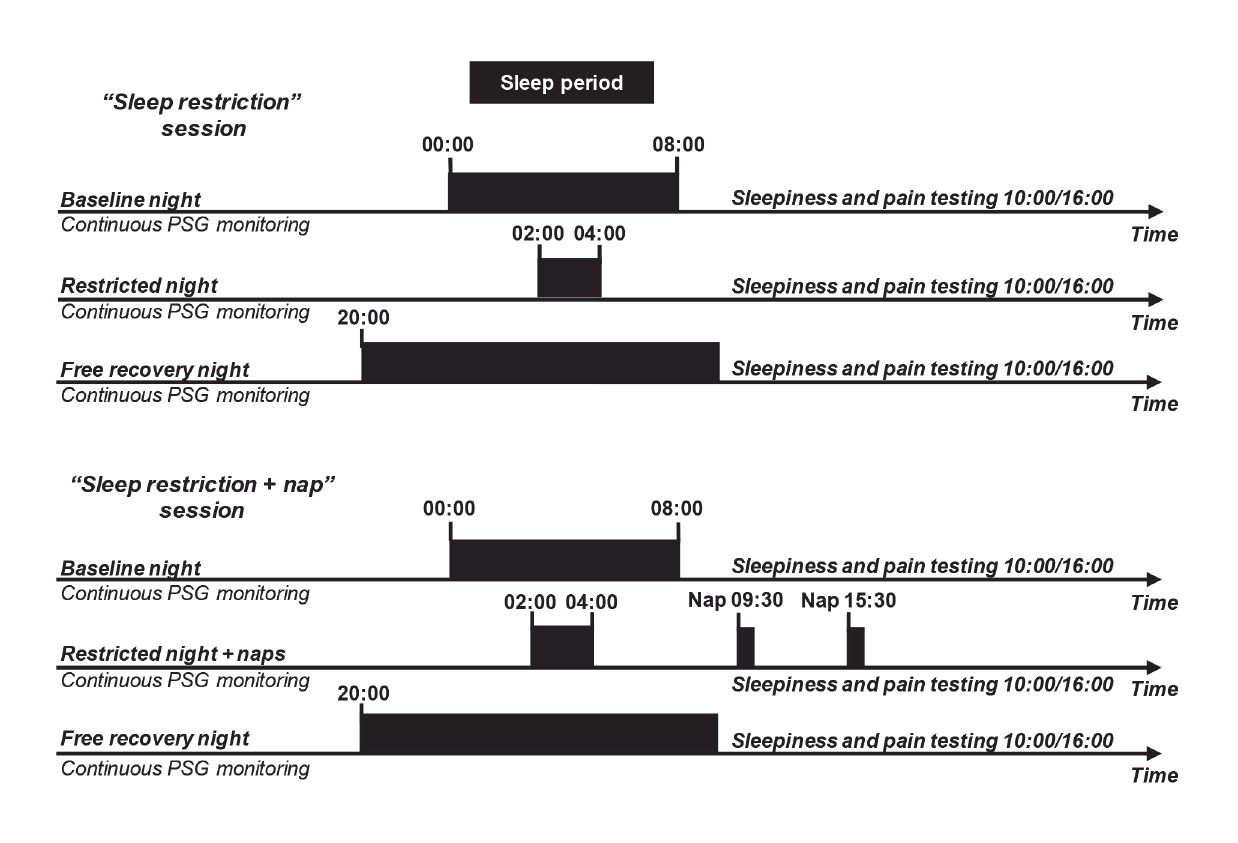
Fig 1. Experimental design. The experimental design included two three-day sessions, during which continuous ambulatory polysomnography (PSG) recordings were taken for each volunteer. The volunteers were randomly allocated to two groups, one of which started with the “ sleep restriction ” session, the other group beginning with the “ sleep restriction + nap ” session. In the “ sleep restriction ” session, the volunteers were allowed to sleep for only two hours during one night (in bed from 02:00 to 04:00), the previous night of 8 hours of sleep being used as the baseline (in bed from 00:00 to 08:00). The night after sleep deprivation, the volunteers were allowed to sleep from 20:00 until spontaneous awakening, for recovery. In the “ sleep restriction + nap ” session, the volunteers repeated the protocol described for the sleep restriction only session, but were allowed to take 30-minute naps at 09:30 and 15:30 on the day following the night of sleep restriction. Subjective sleepiness was assessed and QST was carried out each day, at 10:00 and